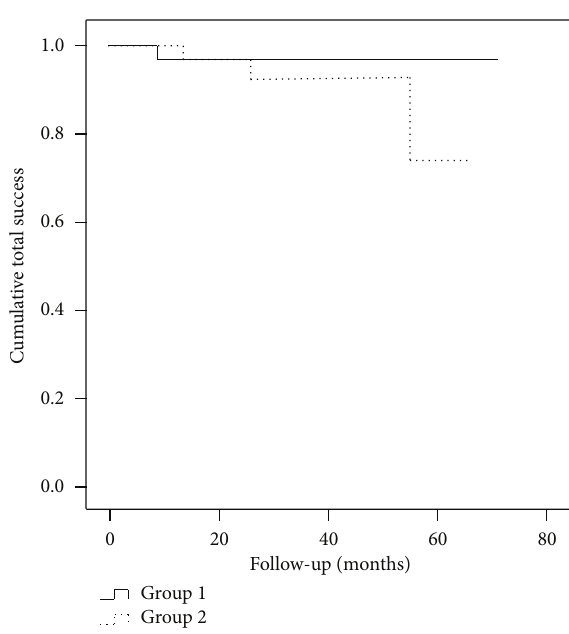
Figure 2: Life-table curves of cumulative total success rates in group 1 (primary open angle glaucoma and pseudoexfoliative glaucoma patients, 𝑛 = 38 ) and in group 2 (uveitic glaucoma patients, 𝑛 = 41 ). The difference calculated for the entire follow-up period was not statistically significant (log-rank 𝑃 = 0.223